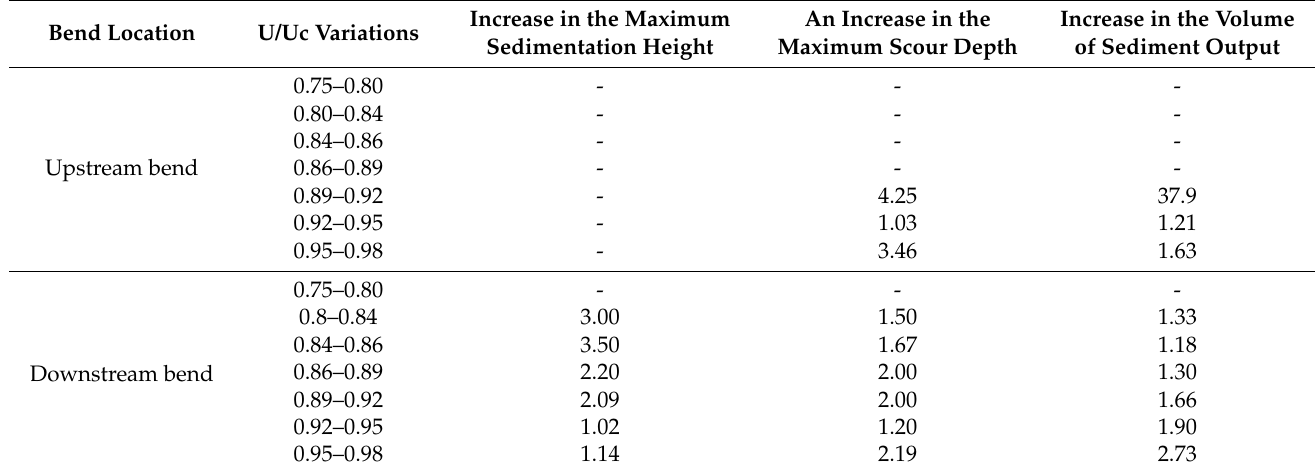
Table 2. Comparison between variations in the maximum scour and sedimentation values for different U/Uc values in the meandering channel.